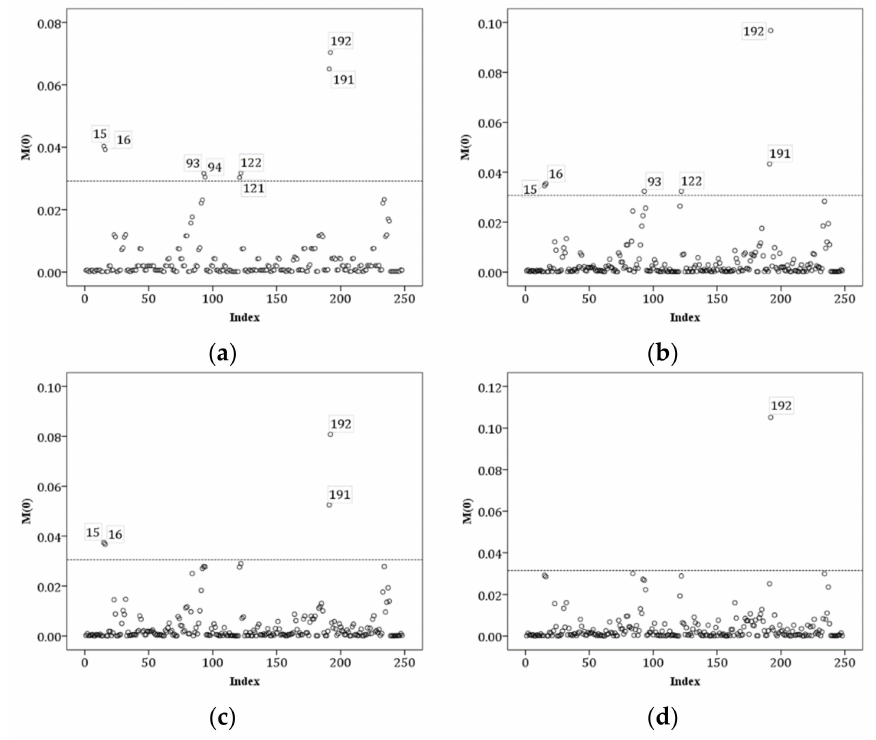
Figure 3. Index plots of M (0) for the perturbation of the response variable for the four scenarios. Dotted lines show the yardstick for M (0) with c ∗ = 3.